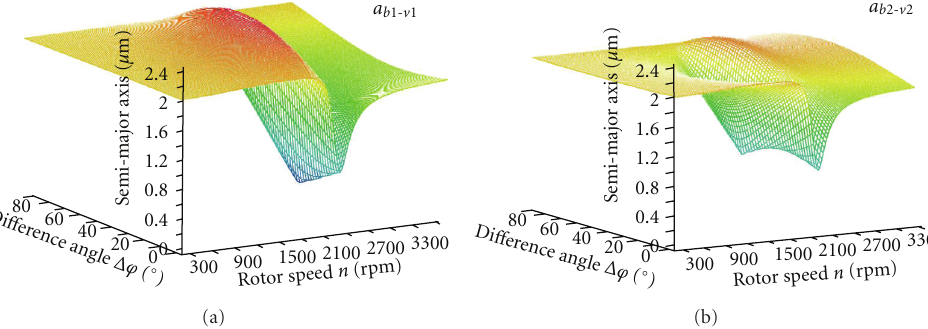
Figure 13: Semi-major axes of the relative orbit (a) between B 1 and V 1 and (b) between B 2 and V 2 , depending on the rotor speed n and on the di ff erence angle Δ ϕ